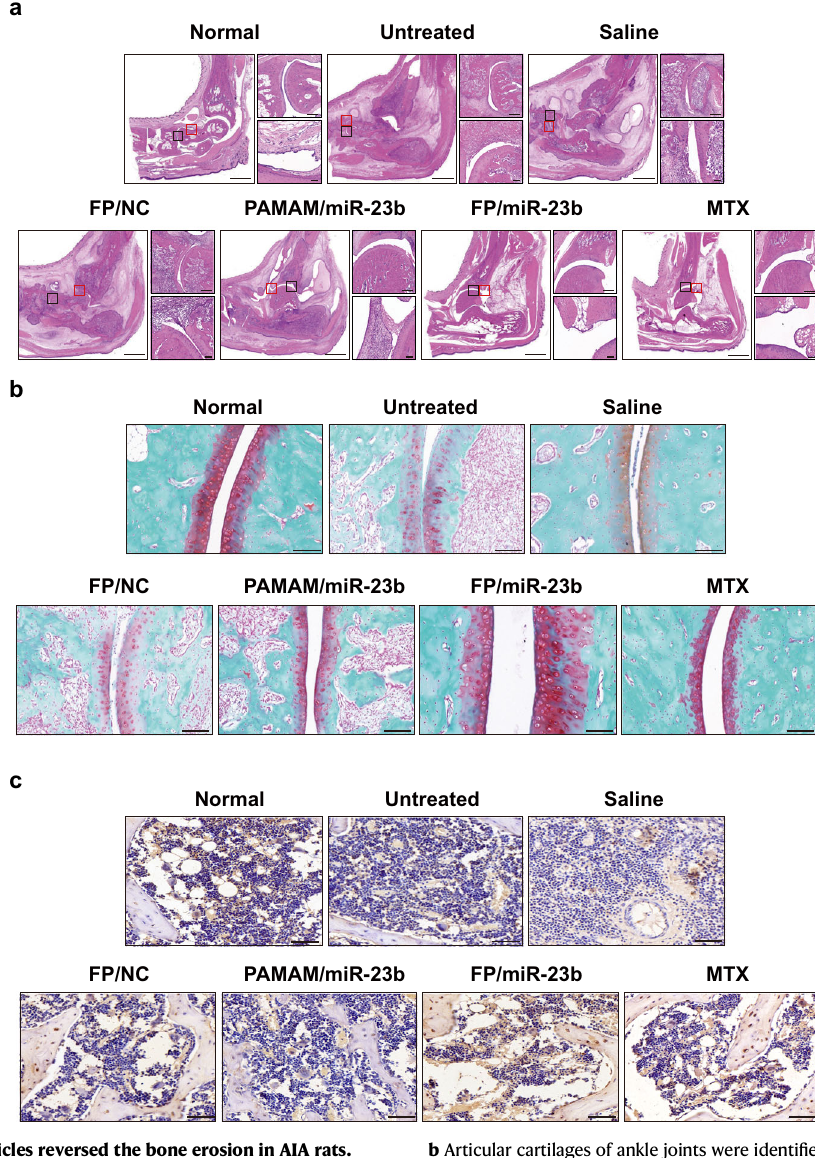
Fig. 7 | FP/miR-23b nanoparticles reversed the bone erosion in AIA rats. a HistologicalchangeofanklejointswasanalyzedbyH&Estaining.Scalebar:2mm. Black region represents the in fi ltrate of synovial tissues (upper right, scale bar: 200 μ m). Red region represents the bone erosion(bottom right,scale bar: 50 μ m).